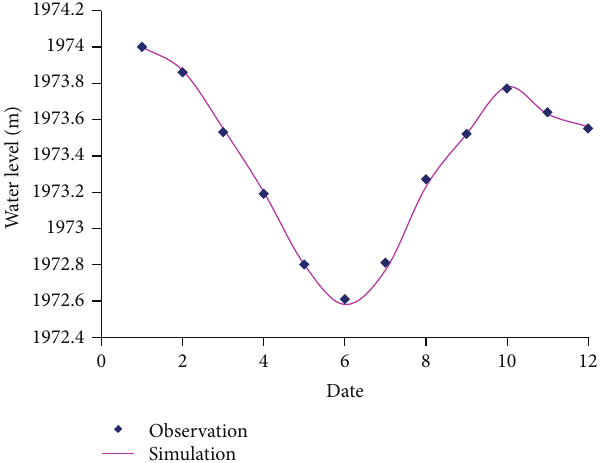
Figure 4: The contrast diagram of simulation value and measured